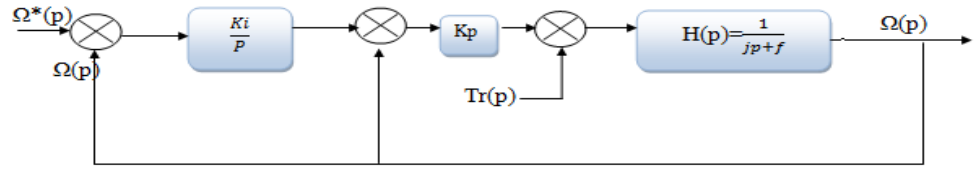
Figure 11. Closed loop IP speed controller.